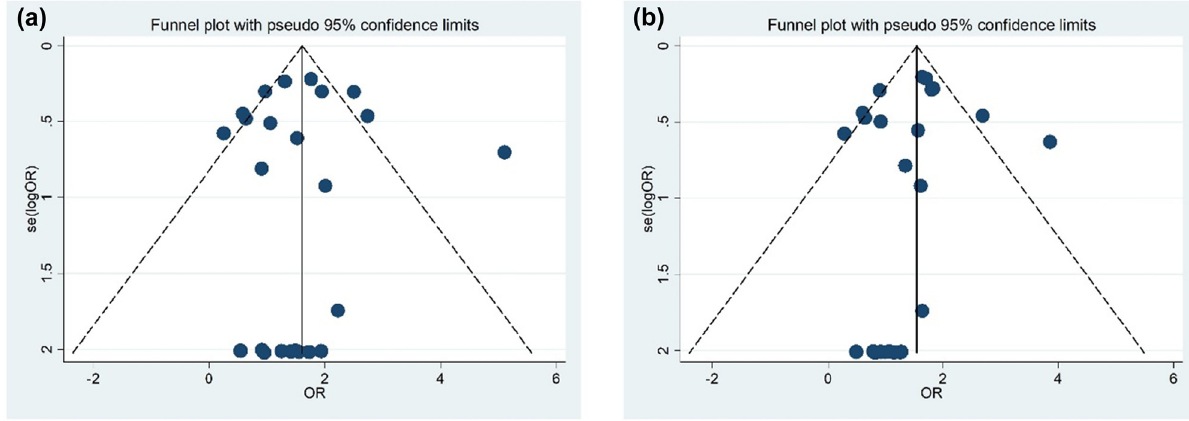
Figure 5: Begg ’ s funnel plot for evaluation publication bias in homologous ( a ) and recessive ( b ) gene